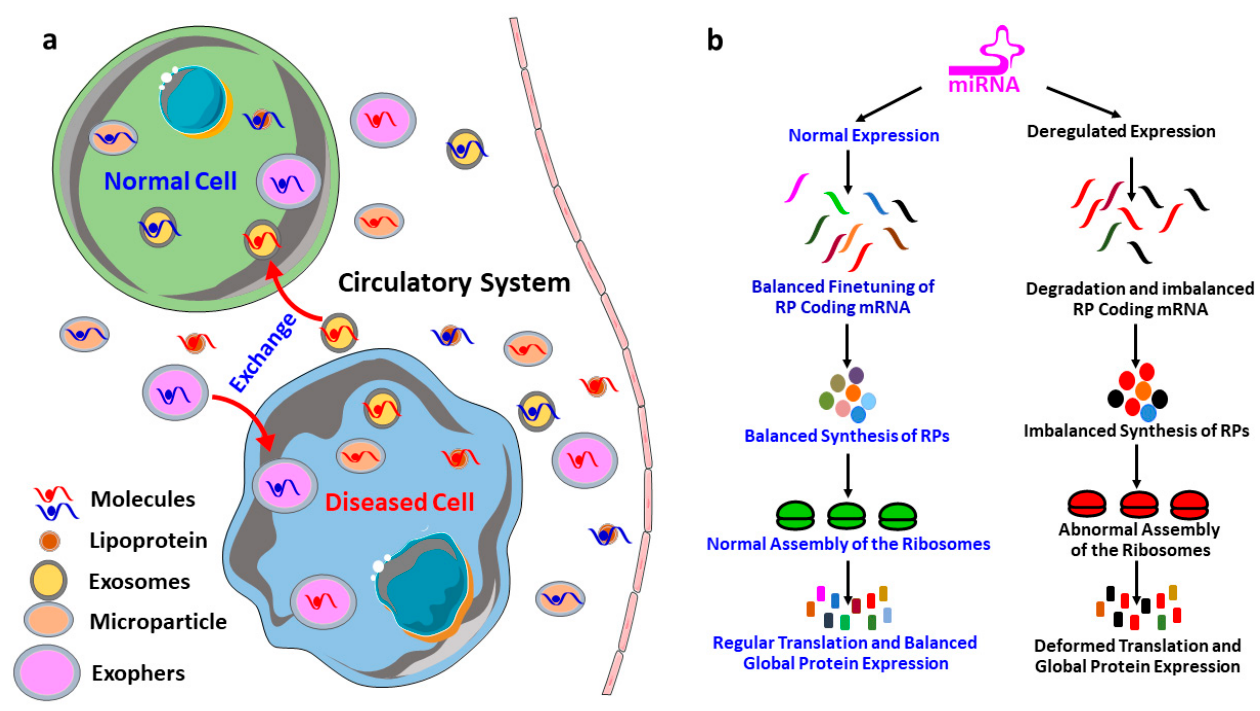
Figure 2. Potential mechanism of microRNA (miRNA) mediated regulation of global protein synthesis. ( a ) Cell-cell and cell-stromal crosstalk: the transportation of the cell secreted miRNAs and proteins by the extracellular vesicles (exosomes, microparticle and exophers) and lipoproteins to the circulatory system, which carries them further to the neighboring cells and the distant organs. ( b ) Deregulated expression of miRNAs might cause an imbalance in the expression of ribosomal proteins (RPs) followed by the abnormal assembly of the protein translation machinery (ribosomes); therefore, the ultimate outcome would be the deregulation of the global protein synthesis.